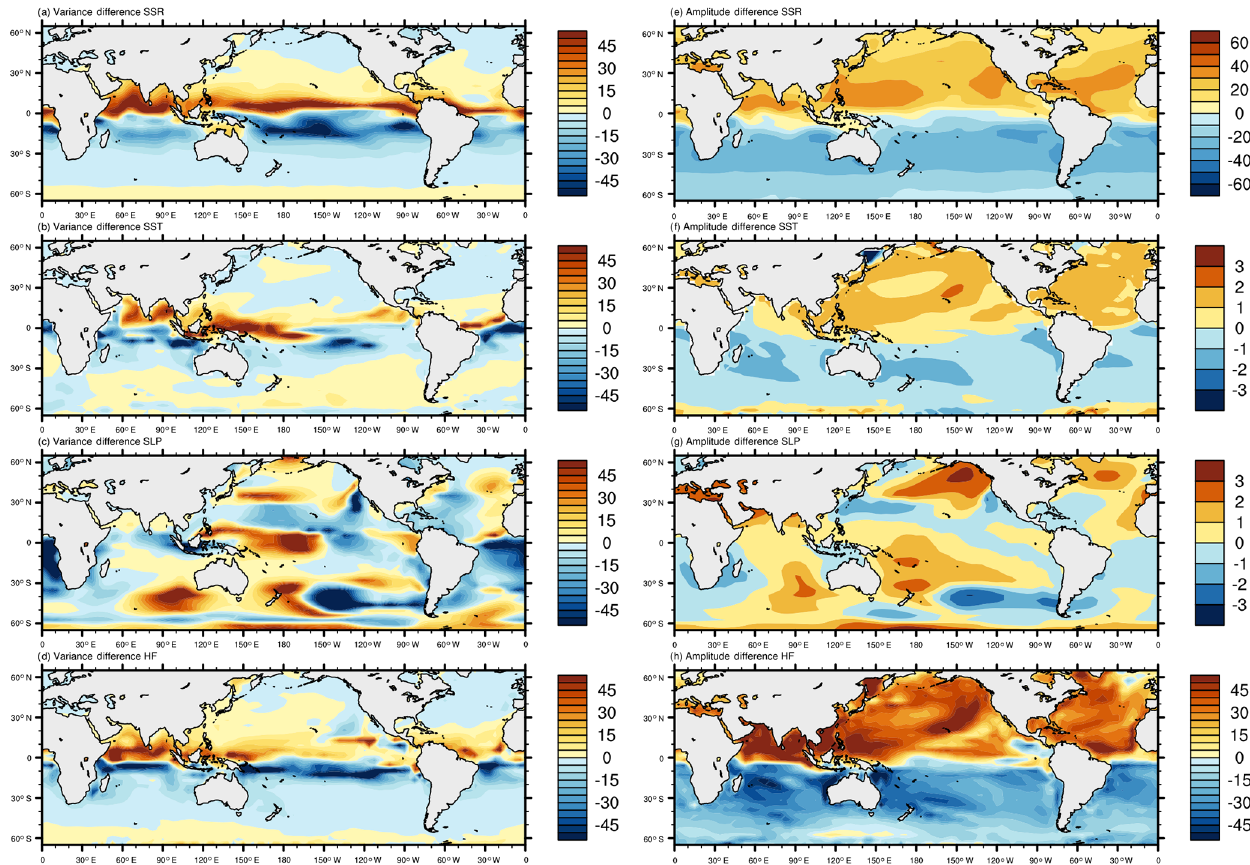
Figure 2. Differences in the first harmonic variance between the MIS31 and CTR run for (a) surface solar radiation (SSR; Wm − 2 ), (b) SST ( ◦ C), (c) SLP (mbar), and (d) surface net heat flux (Wm − 2 ). Panels (e) , (f) , (g) and (h) are the same as (a) , (b) , (c) and (d) but for the first harmonic